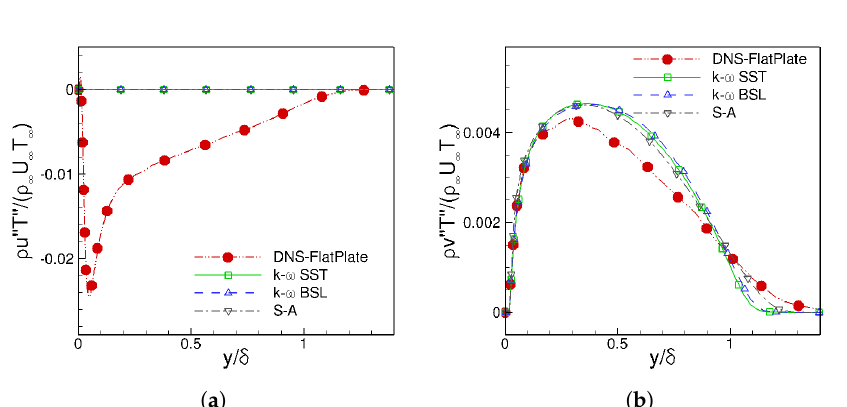
Figure 7. Comparison of turbulent heat fluxes at Re τ ≈ 500 between RANS and DNS. ( a ) turbulent transverse heat flux ρ u (cid:48)(cid:48) T (cid:48)(cid:48) ; ( b ) turbulent normal heat flux ρ v (cid:48)(cid:48) T (cid:48)(cid:48) .